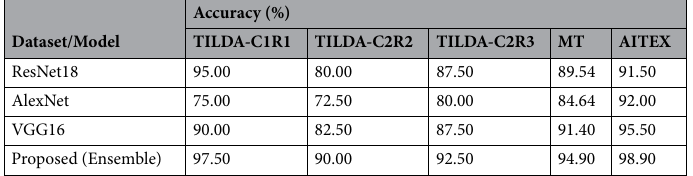
Table 3. Classification performance using different datasets.